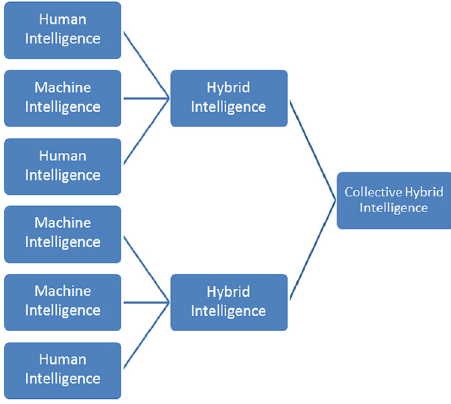
Figure 10. Heterogeneous realization of